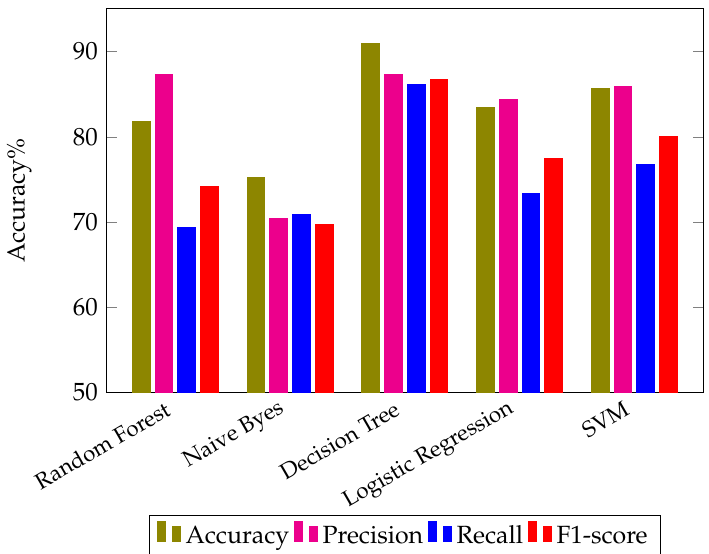
Figure 5. Machine learning Performance on AstraZeneca